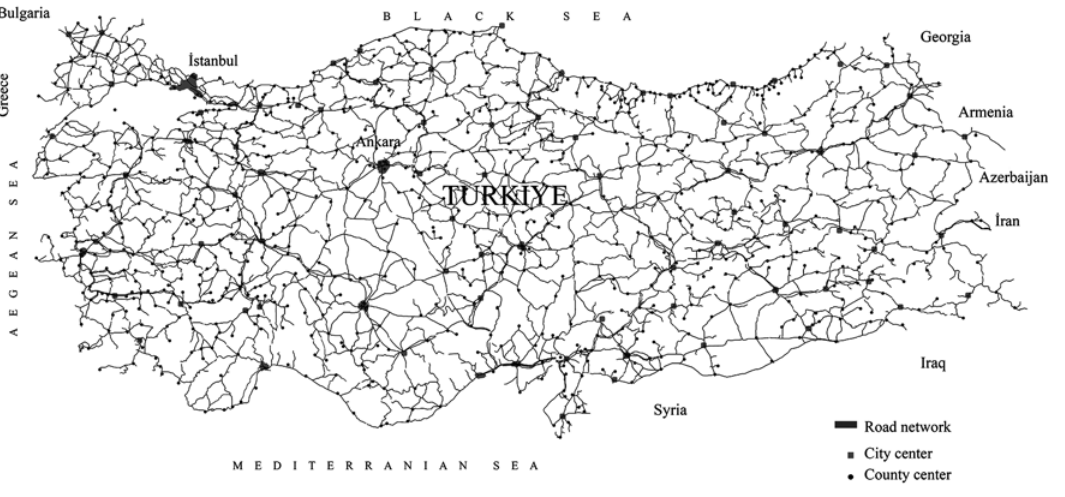
Fig. 2. Map of hydrology network